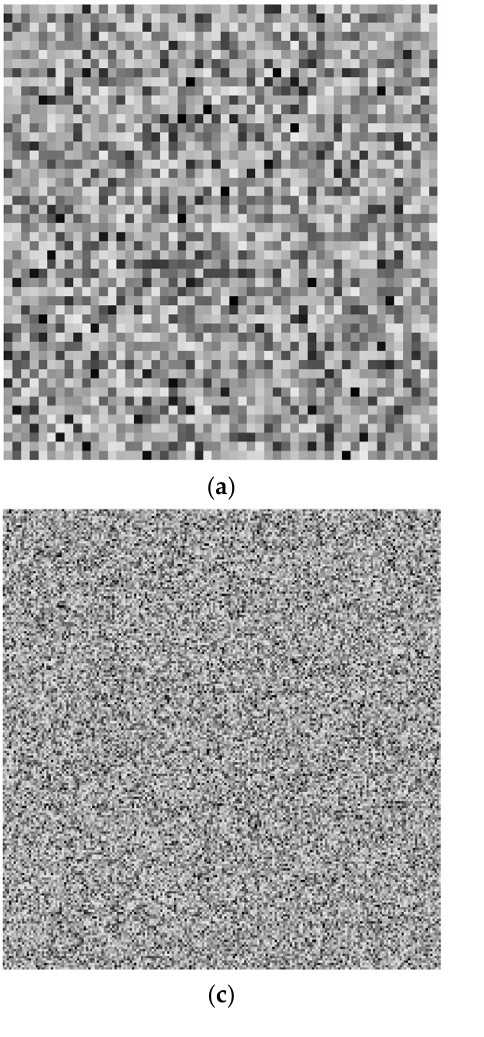
Figure 1. Artificial speckle patterns generated with respect to different speckle sizes, grids of squares: